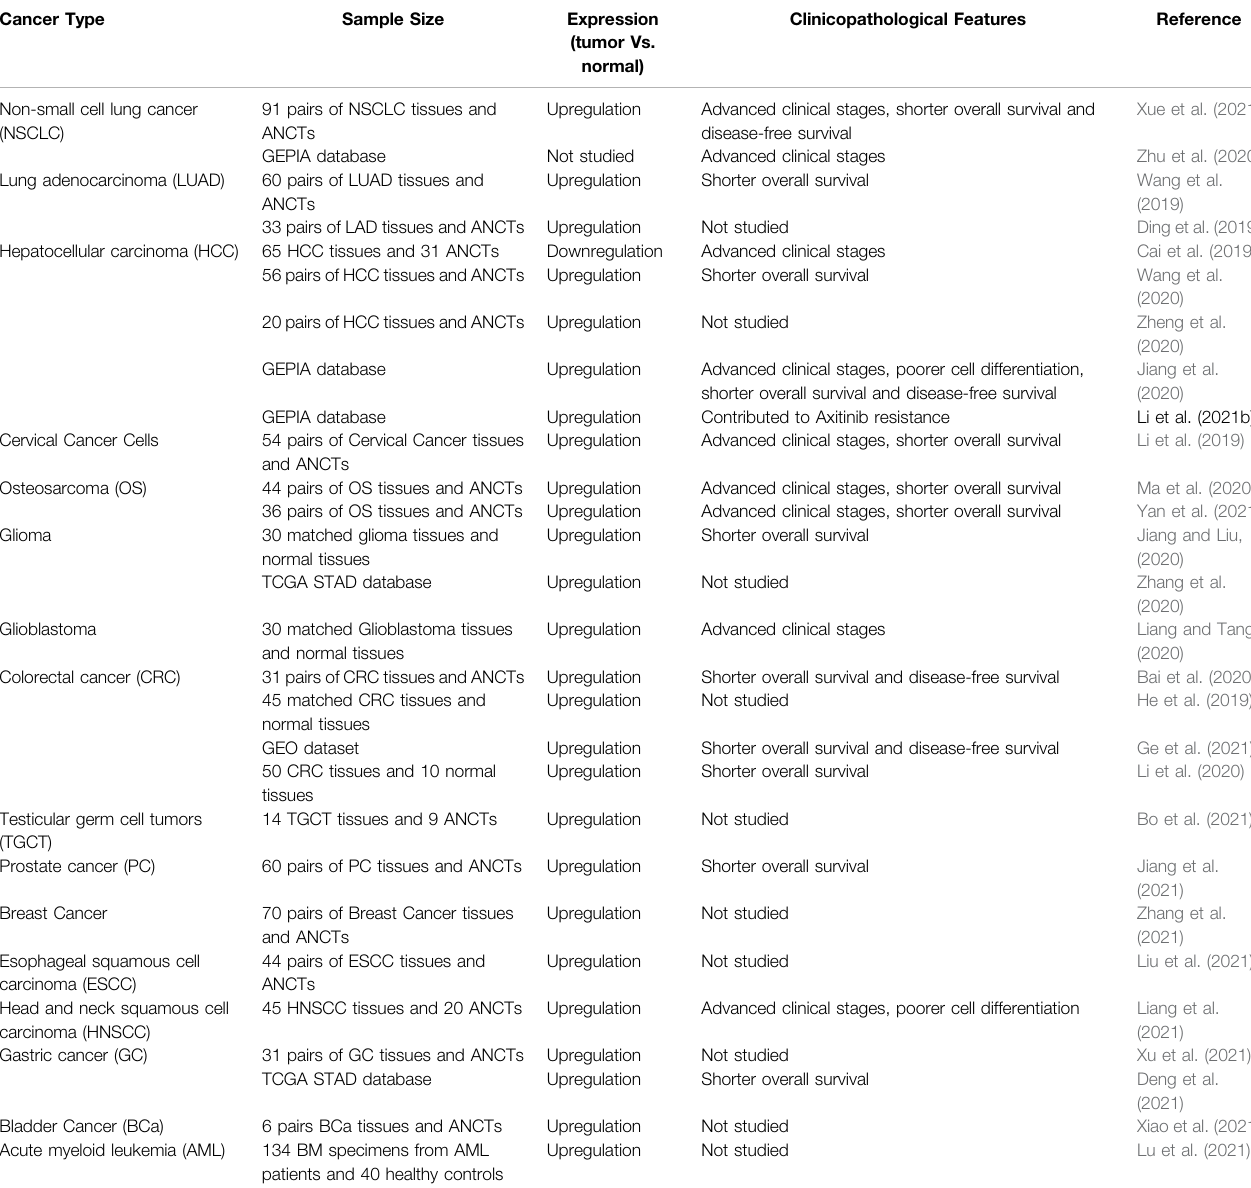
TABLE 1 | Clinical signi fi cance of LINC00467 in various human tumors. (ANCTs: adjacent non-cancerous tissues). Cancer